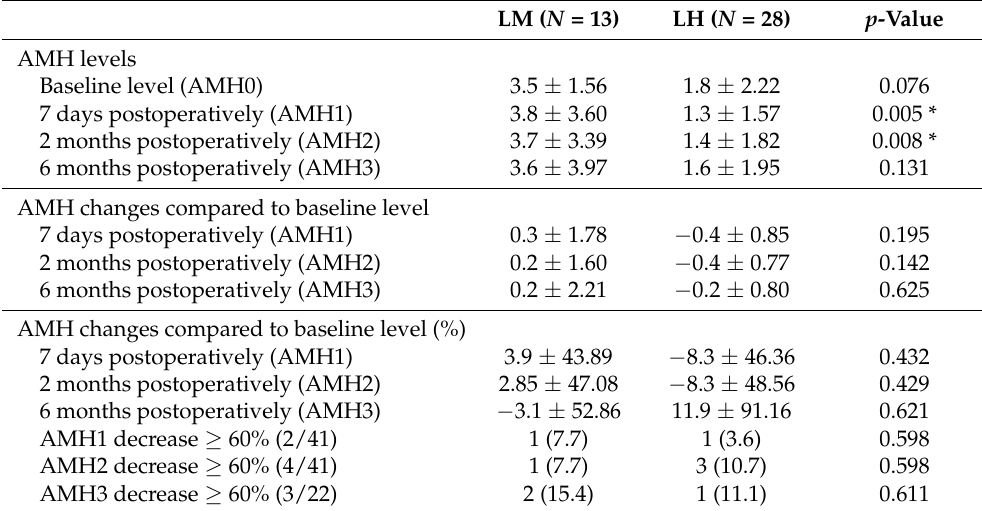
Table 3. AMH changes compared to the baseline levels in the younger age group (younger than 45 years